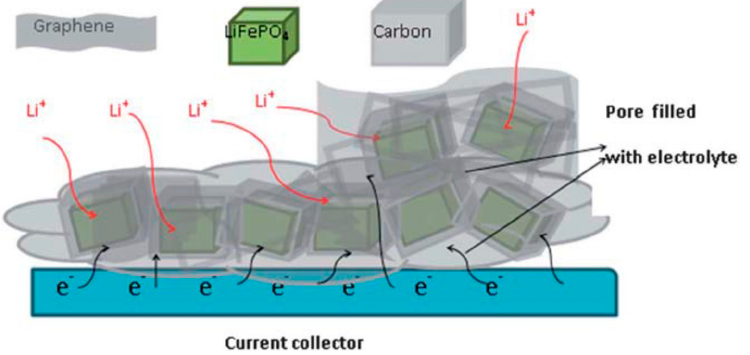
Figure 11. Schematic diagram of the graphene nanosheet/LiFePO 4 structure. Adapted with permission from [111], © Royal Society of Chemistry, 2012.